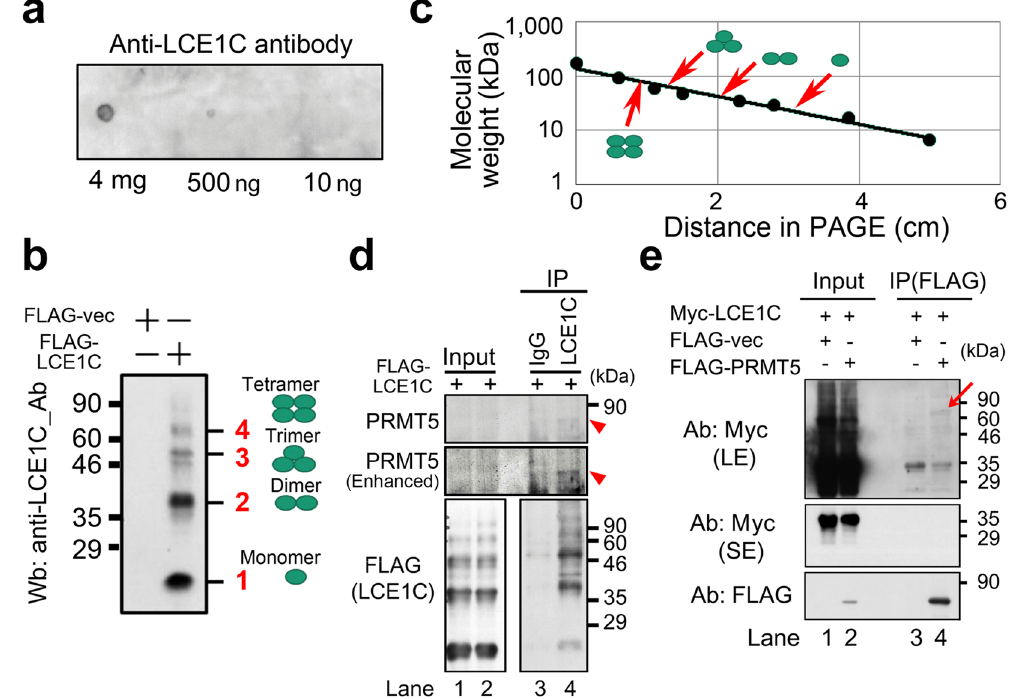
Figure 4. LCE1C is comprised of oligomers and interacts with PRMT5. ( a ) Dot blot analysis of the homemade anti-LCE1C antibody in which the denoted amount of antigen peptide (TPKCPPKCPTPKCPP) was dotted on the Wb filter. ( b ) Wb on the cell extracts from 293T cells expressing FLAG-vector alone or FLAG-LCE1C. Putative bands highlighted by red font (1, 2, 3, and 4) indicate monomer, dimer, trimer, or tetramer forms of LCE1C proteins. ( c ) A line graph shows a linear distribution of migration distance in SDS-PAGE used for Wb and molecular weight of LCE1C. Red arrowheads correspond to the band for indicated oligomers. ( d ) Co-IP on extract of 293T cells expressing FLAG-LCE1C shows an interaction of FLAG-LCE1C tetramer with PRMT5 (red arrowhead). ( e ) Co-IP on extract of 293T cells expressing Myc-LCE1C and/or FLAG-PRMT5 shows an interaction of FLAG-LCE1C tetramer with FLAG-PRMT5 (red arrow). LE; long exposure onto X-ray film. SE; short exposure onto X-ray film. Red arrow indicates a band for putative LCE1C